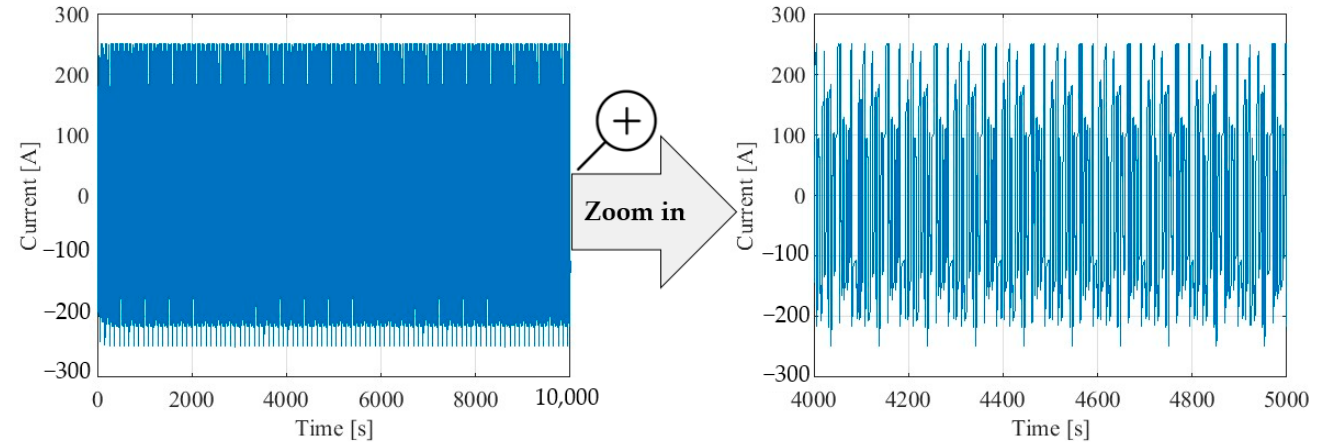
Figure 3. ( Left ) Dynamic current profile applied to the LiC cells during 10,000 s from − 250 A to +250 A current rate, ( right ) zoomed frame of the applied dynamic current from 4000 s to 5000 s that shows the dynamic behavior of the applied current rate.